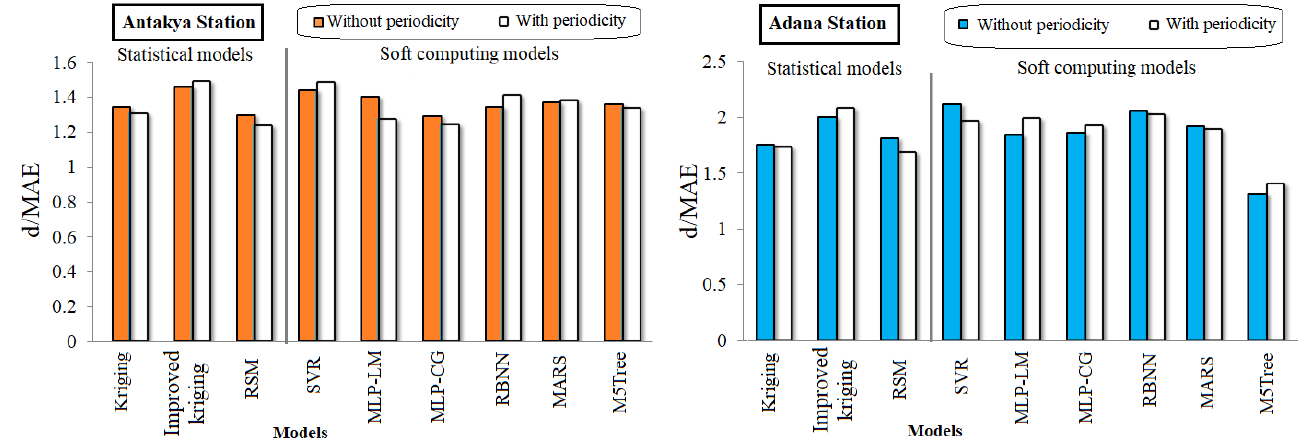
Figure 8. Bar charts showing the d / MAE ratio for the applied models in the testing period for Adana and Antakya Stations.